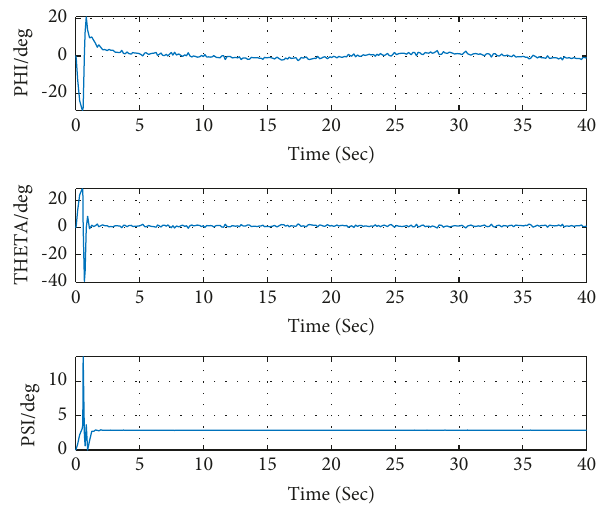
Figure 17: The curve of attitude